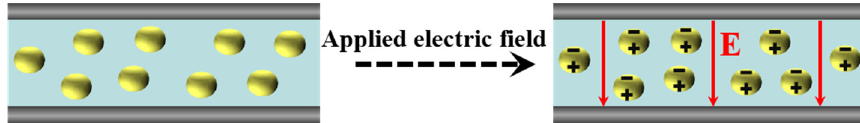
Figure 1. Polarization under electric fields.